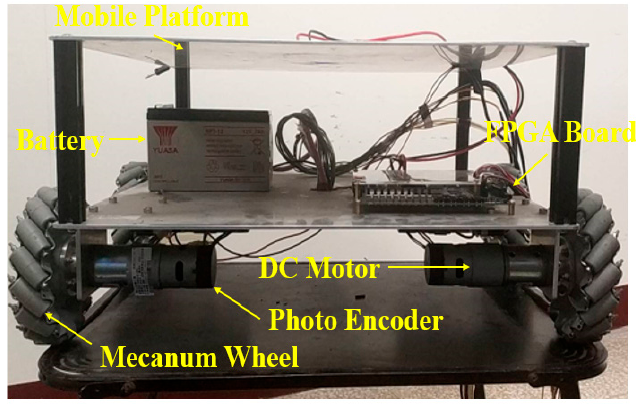
Figure 5. Cyber-physical Mecanum vehicle with FPGA realization.